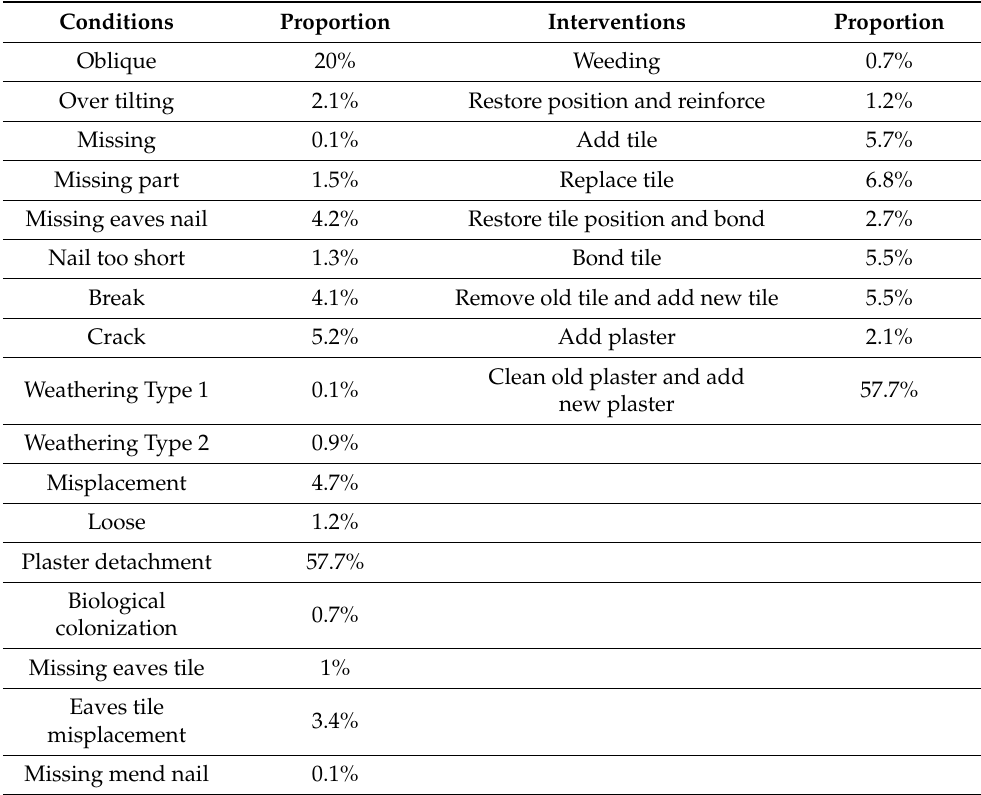
Table 2. The proportion of the condition and